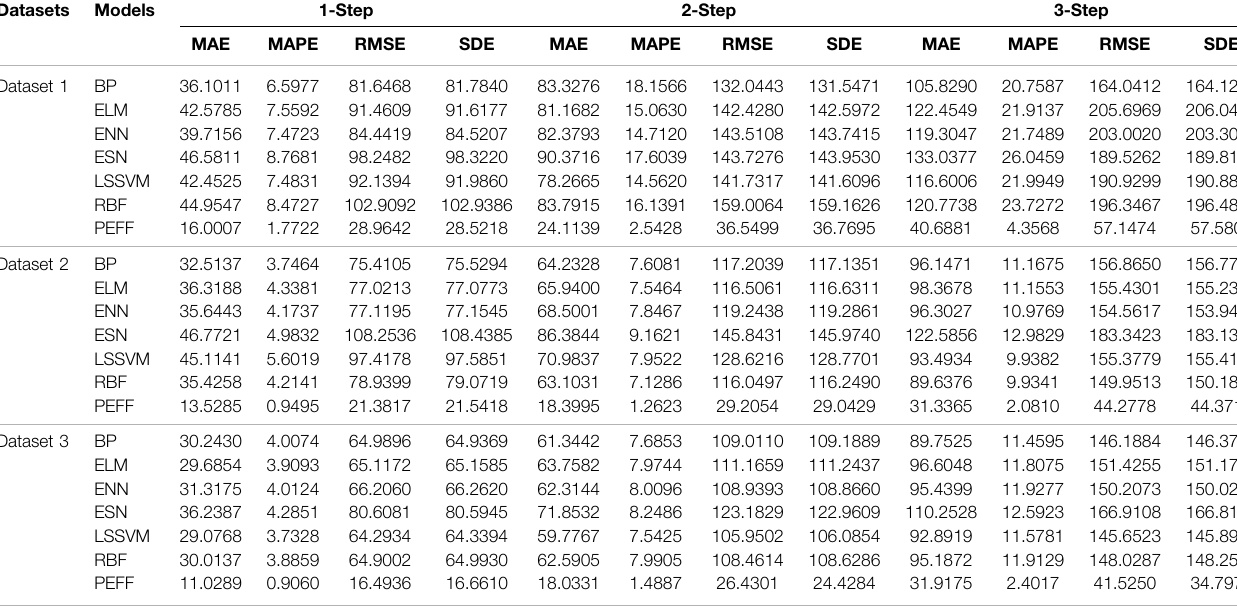
TABLE 6 | Comparison of the prediction performance of the PEFF and reference models. Datasets